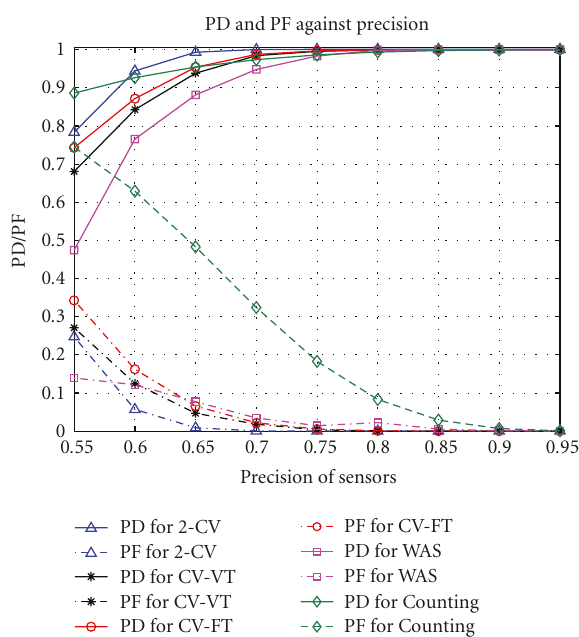
Figure 8: Numerical plots of system level probability of detection ( PD ), probability of false alarm ( PF ) with respect to precision of sensors p for various aggregation schemes.